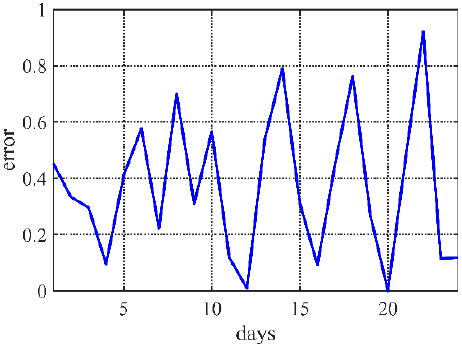
Figure 5. The error of several days.